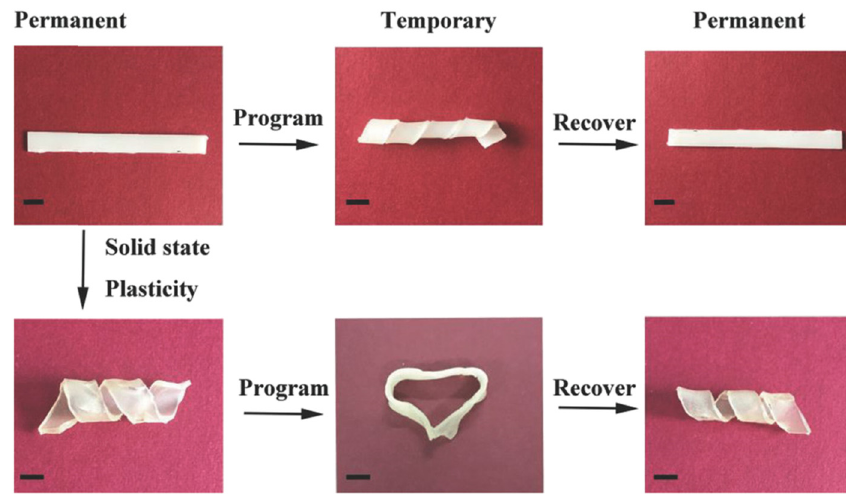
Figure 2: Manipulation of PCL - based polymer via plasticity, followed by conventional shape fi xing and recovering. Copyright 2018, John Wiley & Sons – Books ( 71 )